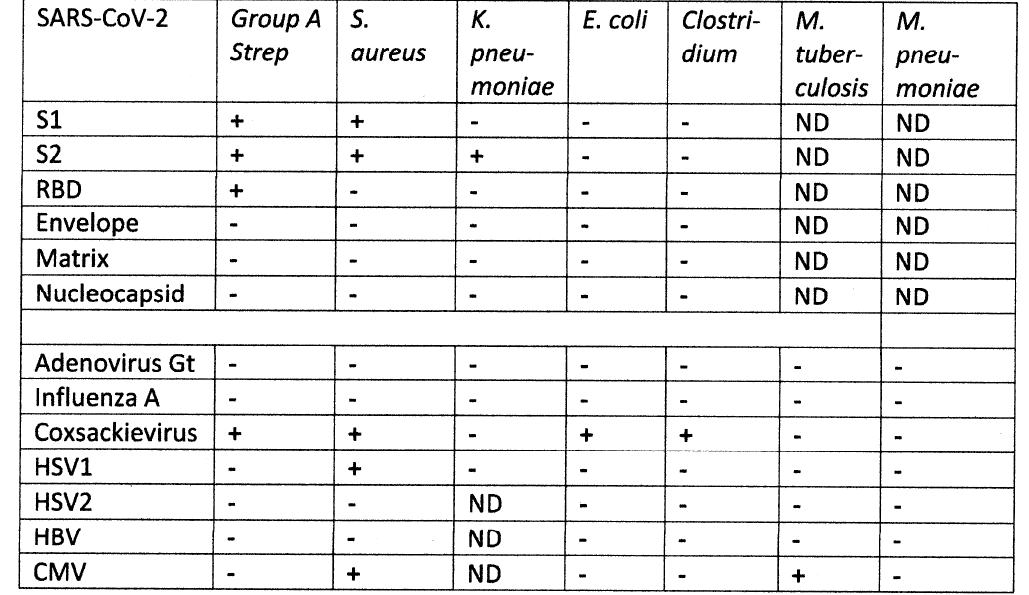
Figure 14. Summary of experimental studies of the binding of viral antibodies (left-hand column) to bacterial antibodies (top row) [69,70]; additional data from [20,21]. The plus signs indicate nanomolar binding between the antibody pair; minus signs indicate insignificant (micromolar or no observable binding) between the antibody pair. ND means that combination was not tested. S1, S2, RBD, envelope, matrix and nucleocapsid refer to specific proteins of the SARS-CoV-2 virus. Influenza A = influenza A virus; HSV = human herpes virus; HBV = hepatitis B virus; CMV = human cytomegalovirus; Strep = Streptococci .